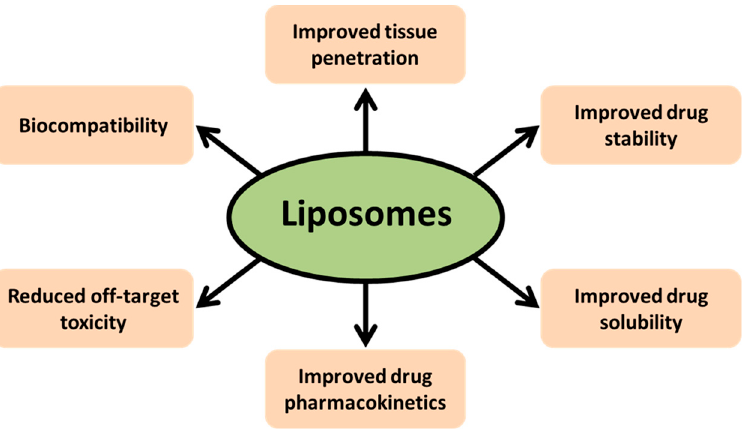
Figure 1. Advantages of liposomes as drug delivery systems.